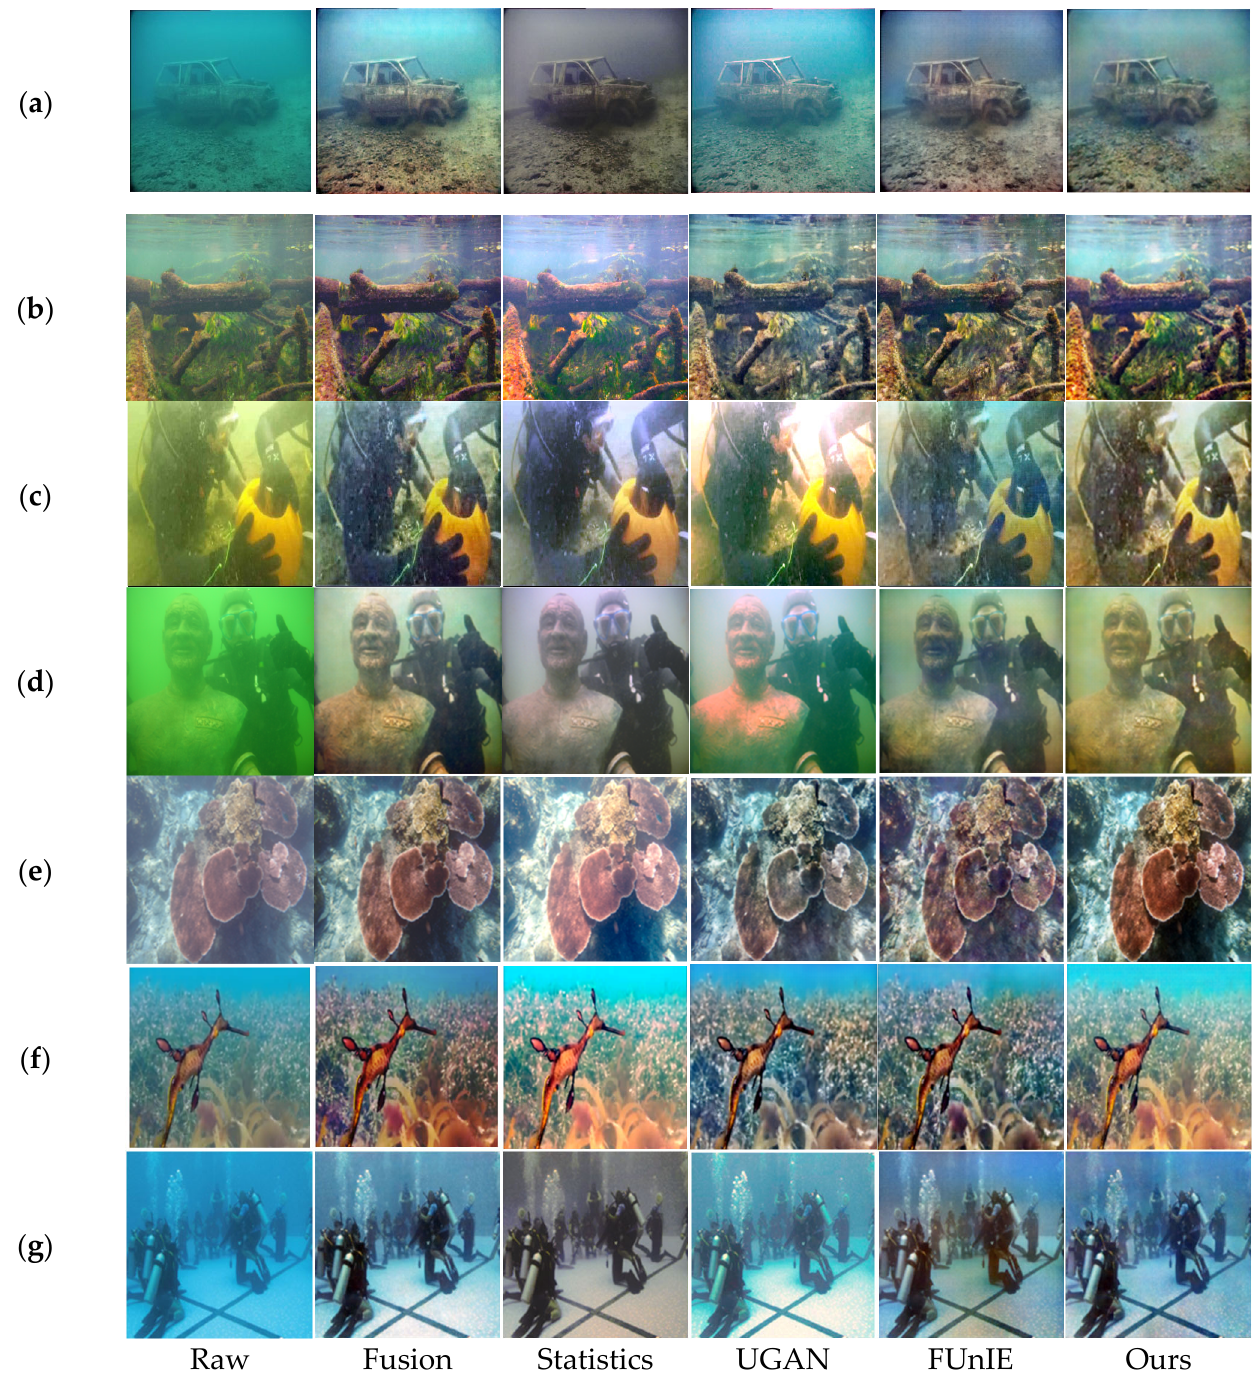
Figure 3. Subjective comparisons on real ‐ world underwater images. From top to bottom are ( a – g ). From left to right are raw underwater images, the results of Fusion based [3], Statistics based [23], UGAN [8], FUnIE [9] and Ours.